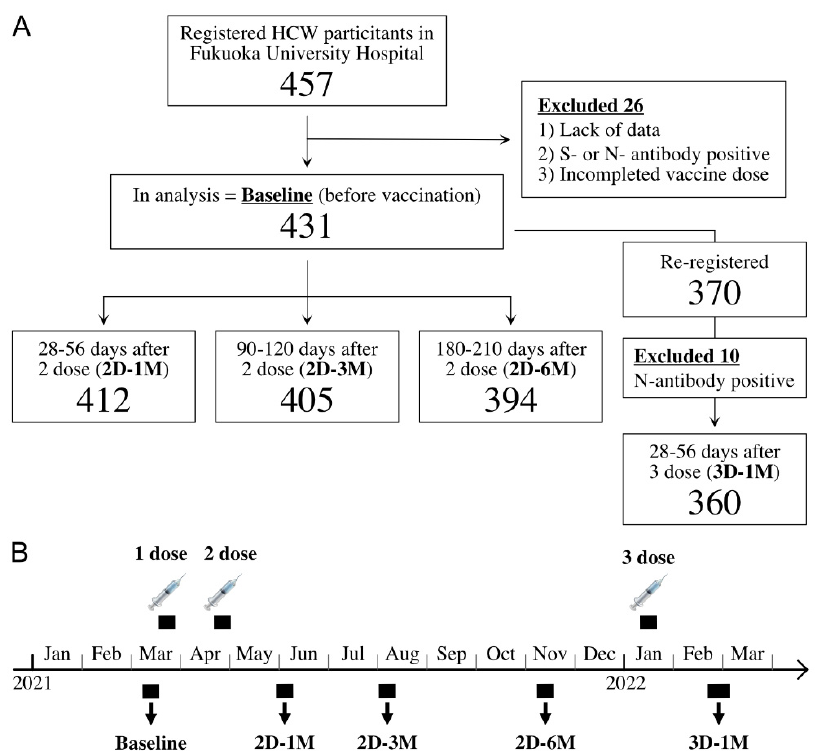
Figure 1. Cohort diagram and schedules of BNT162b2 vaccinations and blood samplings. This is a prospective observational study of HCWs who received two doses of the BNT162b2 vaccine fol- lowed by a third dose of BNT 162b2 with 8 M intervals. Participants were followed three times after the second dose: 2D-1M (28–56 days), 2D-3M (90–120 days) and 2D-6M (180–210 days). Blood sam- plings were also collected at 1 M after the third dose of BNT162b2 vaccination from the participants (3D-1M).